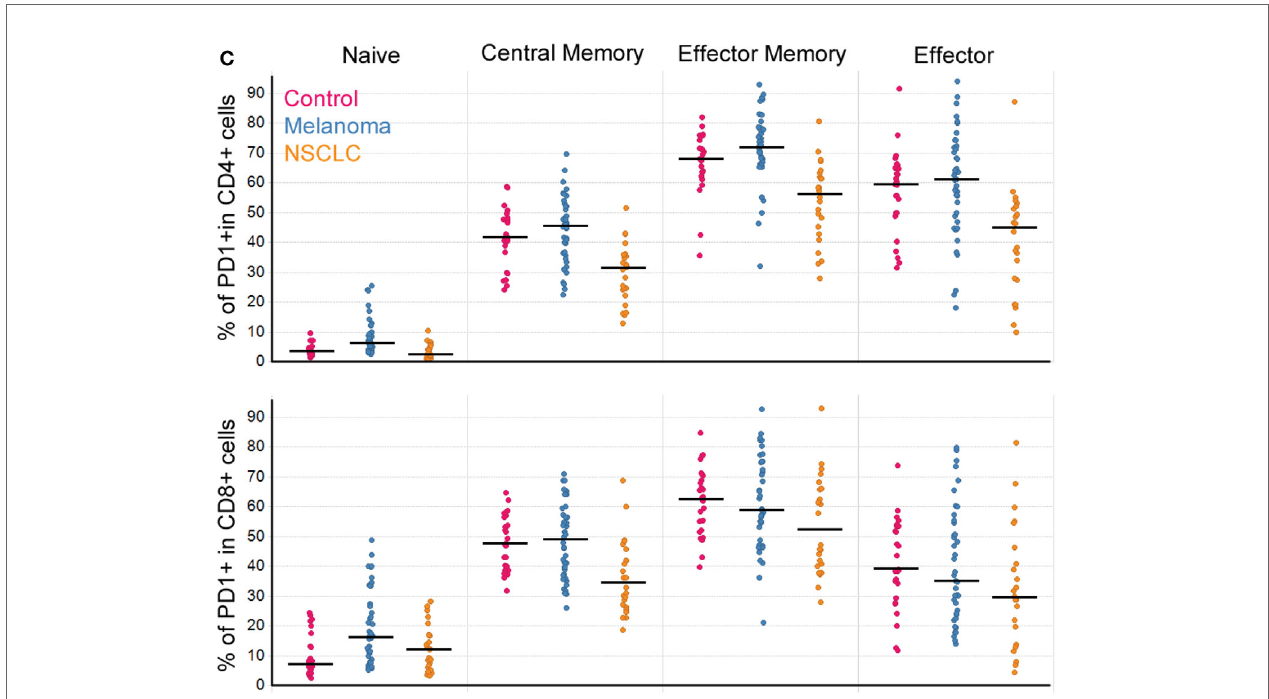
FigUre 1 | Peripheral T cell subpopulations show evidence of an ongoing immune response in cancer patients. (a) Gating strategy to define T cell subpopulations in PBMC. (b) CD4 + and CD8 + T cell subpopulations in PBMC from melanoma and NSCLC patients. (c) Percentage of PD1 + cells per T cell subpopulation (controls n = 27, melanoma n = 43, NSCLC n = 40; Bonferroni-corrected p -values: * < 0.001). Line marks the